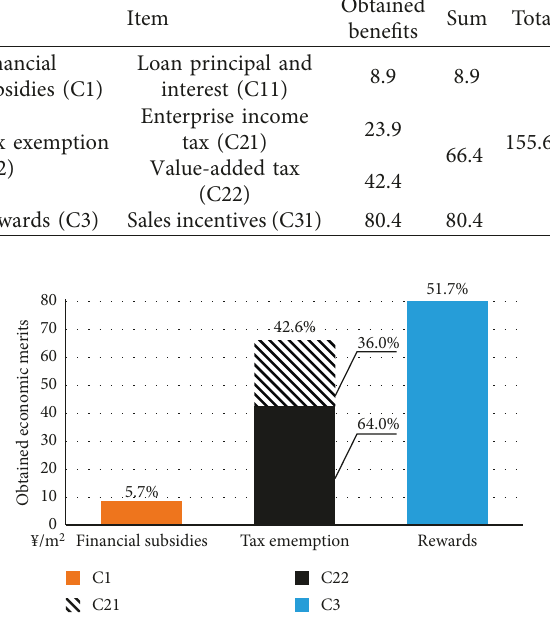
Figure 9: Economic proportions of indicators from policy